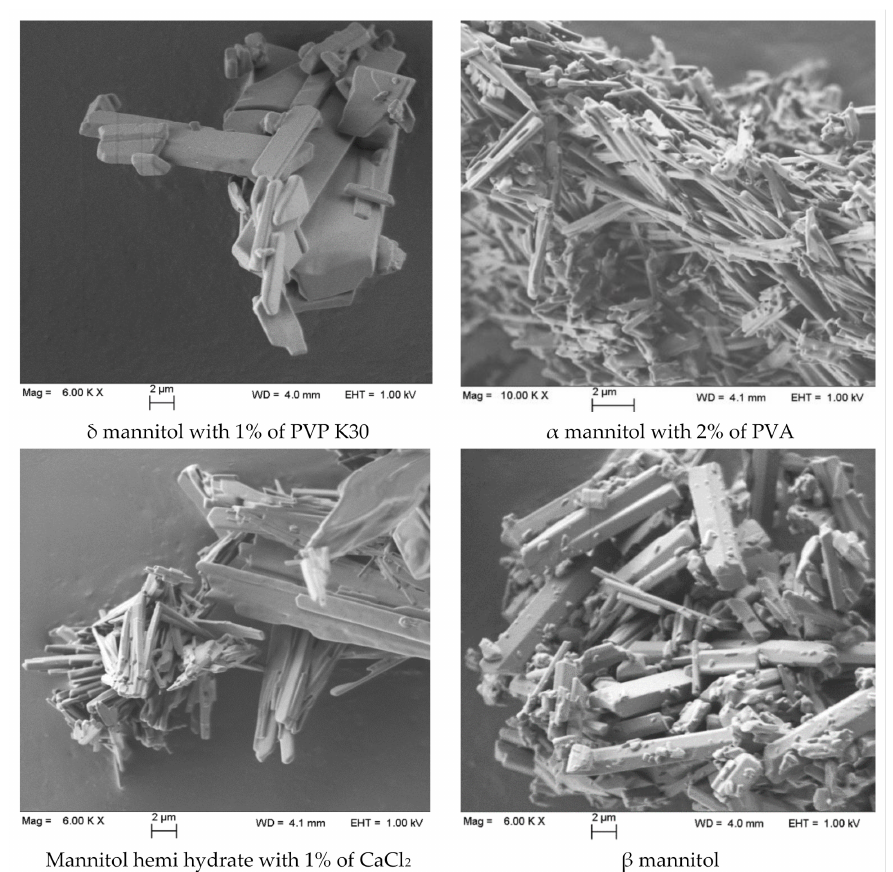
Figure 8. SEM pictures of mannitol forms taken at 6000 × (or 10,000 × in the case of α form) magnification.